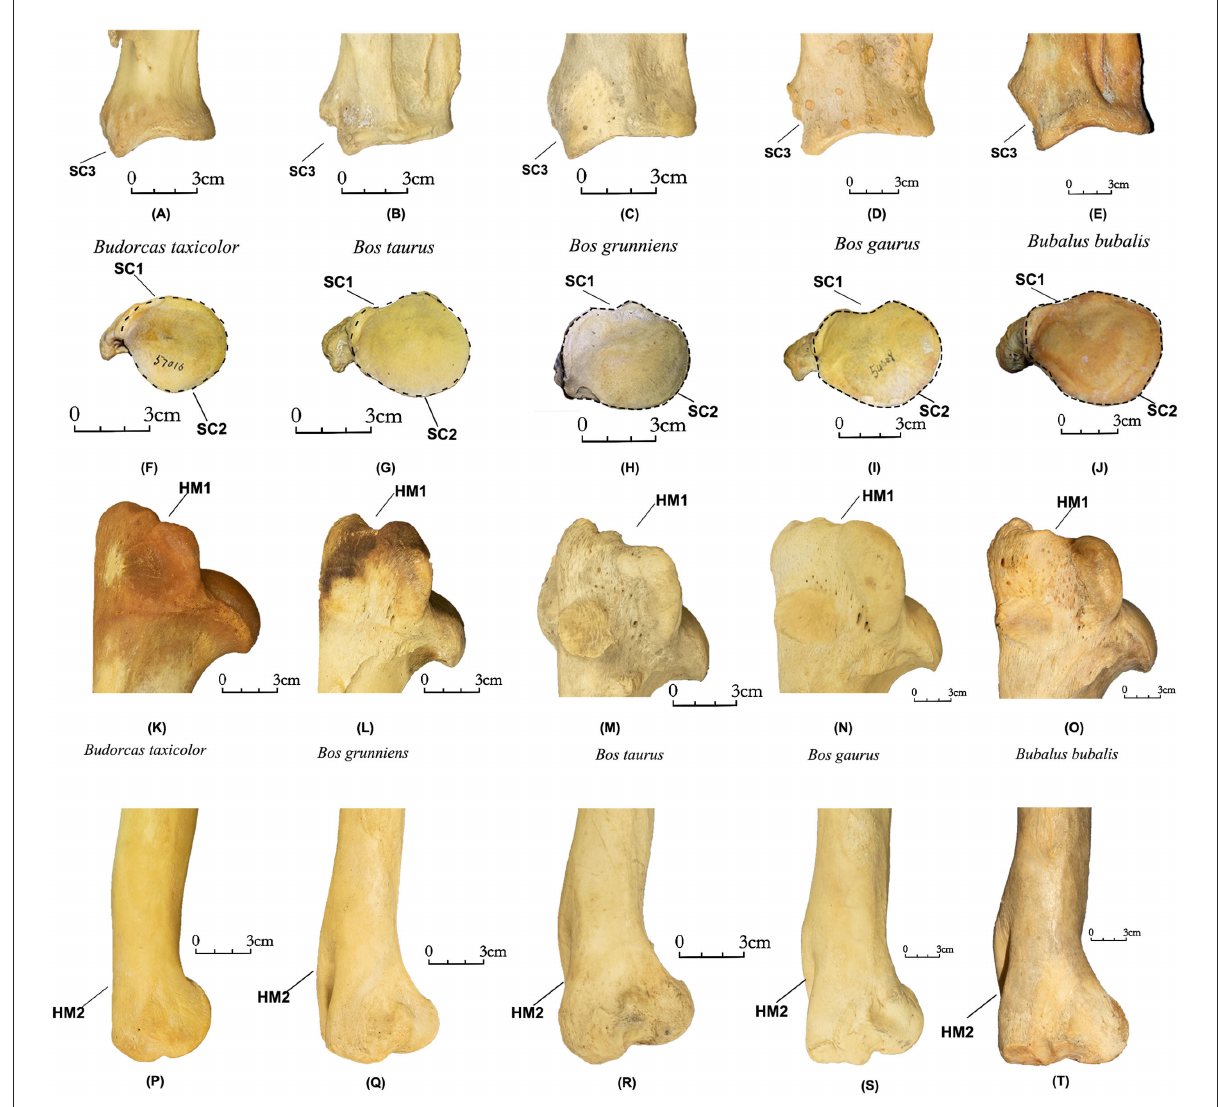
FIGURE3 Scapula and humerus of takins and Bovini. Lateral view of the scapula: (A) Budorcas taxicolor (AMNH–M − 57016), (B) Bos taurus (AMNH − 77932). (C) Bos grunniens (AMNH − 10263). (D) Bos gaurus (AMNH − 54470). (E) Bubalus bubalis (AMNH–M − 54766). Cranioventral view of the scapula: